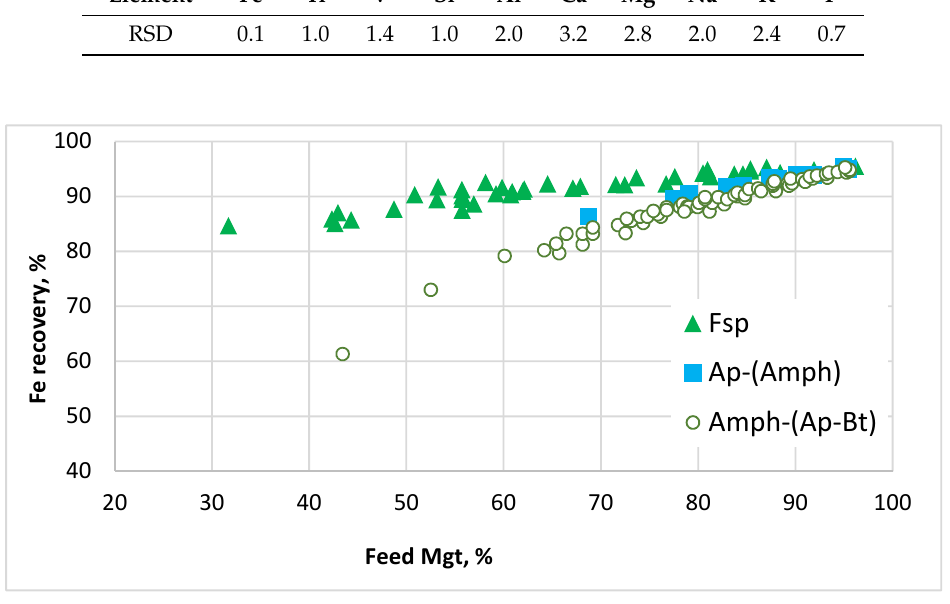
Figure 9. Fe recoveries measured from Malmberget case study (based on [80]).